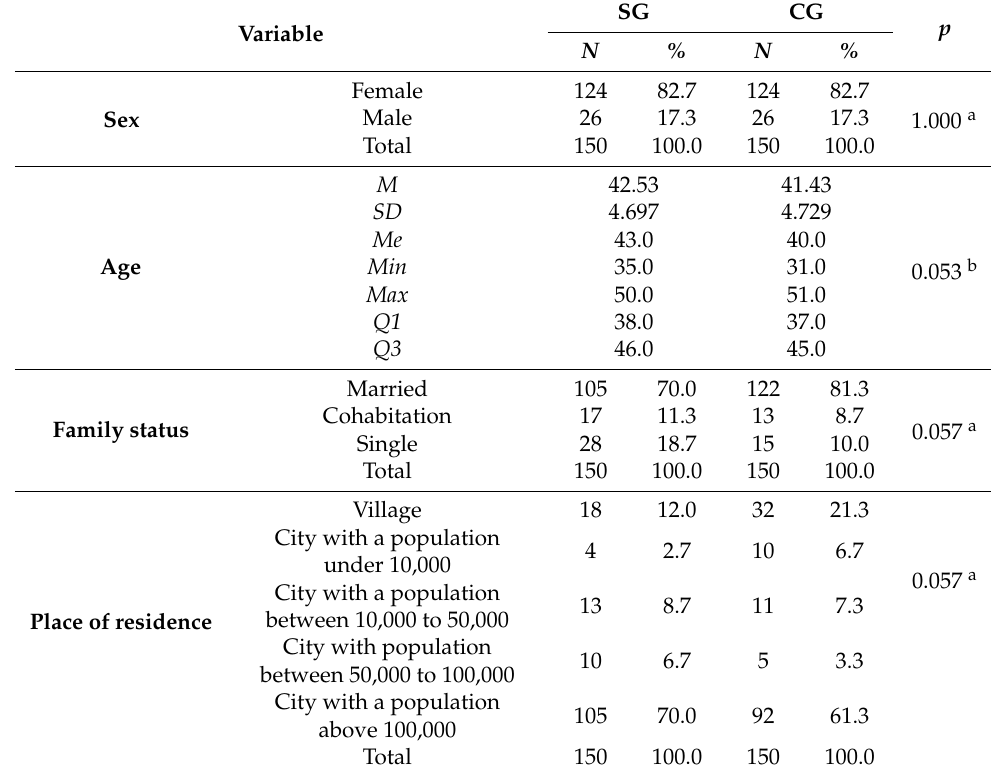
Table 1. Comparative characteristics of socio-demographic data of all study participants.